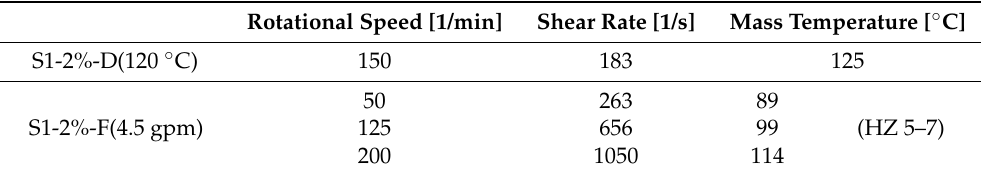
Table 3. The mass temperature in the extruder die and the calculated shear rates for S1-2%D (120 ◦ C) and S1-2%-F (4.5 gpm) for different rotational